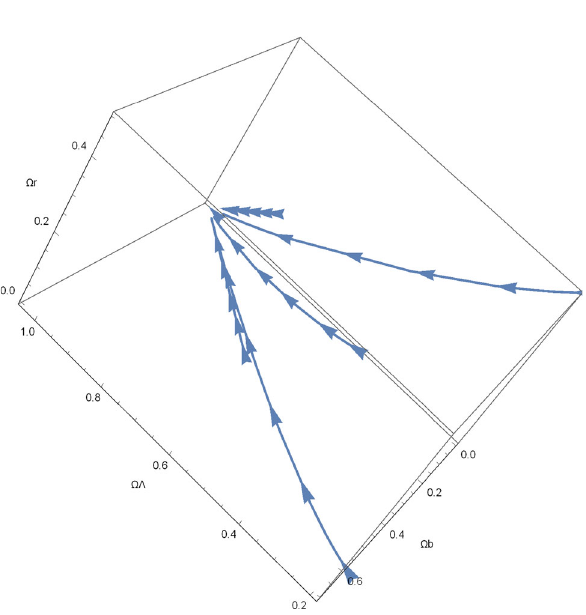
Fig. 5 Phase space diagram for the dynamical system (16), (17), (21). We consider (a) (cid:8) b = 0 . 2996 ,(cid:8) r = 0 . 0004, (cid:8) (cid:2) = 0 . 7, (b) (cid:8) b = 0 ,(cid:8) r = 0 . 1, (cid:8) (cid:2) = 0 . 9, (c) (cid:8) b = 0 . 3, (cid:8) r = 0 . 2, (cid:8) (cid:2) = 0 . 5, (d) (cid:8) = 0, (cid:8) = 0 . 5, (cid:8) (cid:2) = 0 . 2 (e) (cid:8) b r